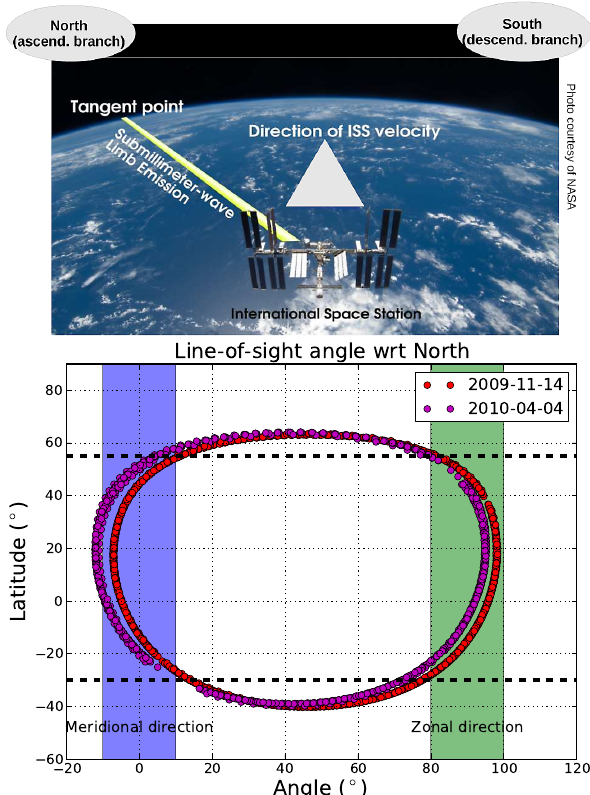
Fig. 2. Upper panel: Representation of the limb observation ge- ometry (adapted from http://smiles.nict.go.jp/pub/about/principles. html). The ISS orbit inclination is 51.6 ◦ with respect to the equator and the SMILES line-of-sight is tilted by 45 ◦ on the left side of the forward direction. The tangent point is at a distance of ∼ 2000km from the ISS. North (South) direction is indicated for the ascending (descending) orbit branch. Lower panel: latitudinal variation of the line-of-sight angle with respect to the North direction on 14 Novem- ber 2009 (red circles) and on 4 April 2010 (magenta circles). The blue (green) region indicates the region where the line-of-sight is between ± 10 ◦ about the meridional (zonal) direction. The thick dashed horizontal lines indicate the latitude range between 30 ◦ S and 55 ◦